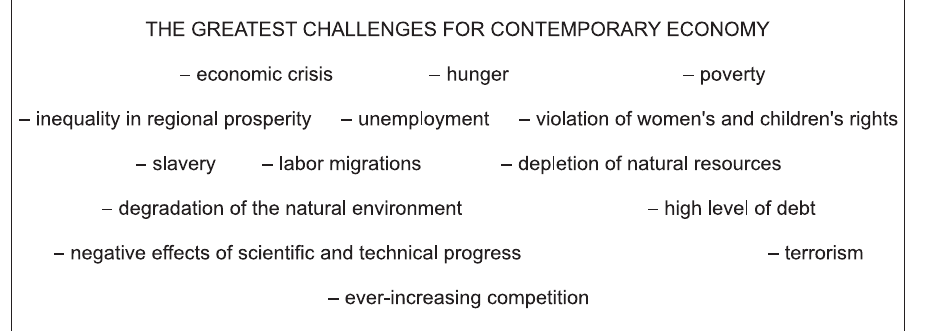
Figure 1. The biggest challenges of the modern economy – selected examples